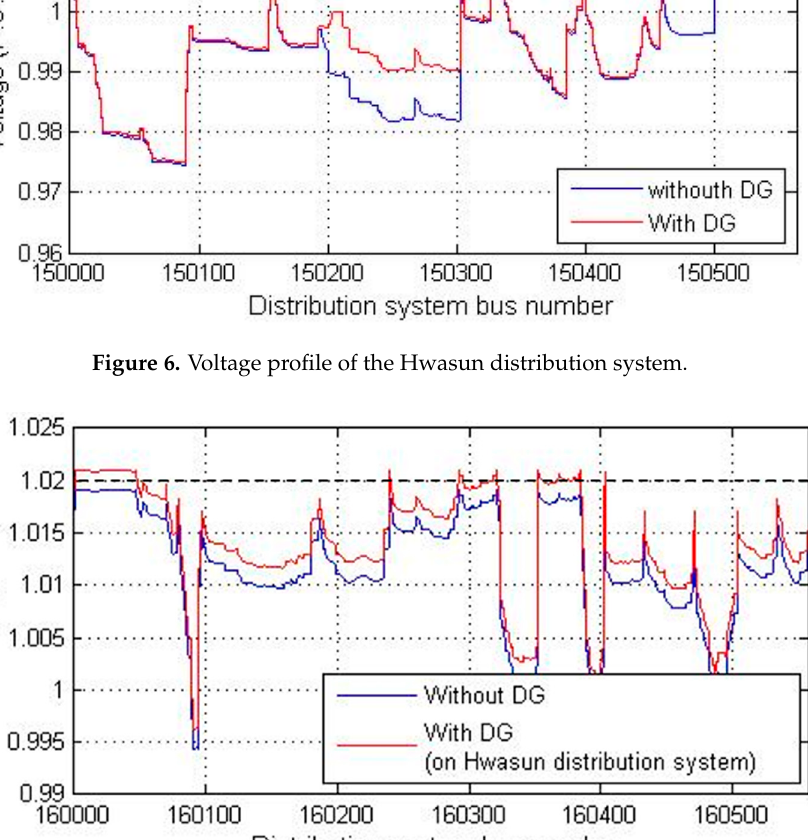
Figure 7. Voltage profile of the South Gwangju distribution system.